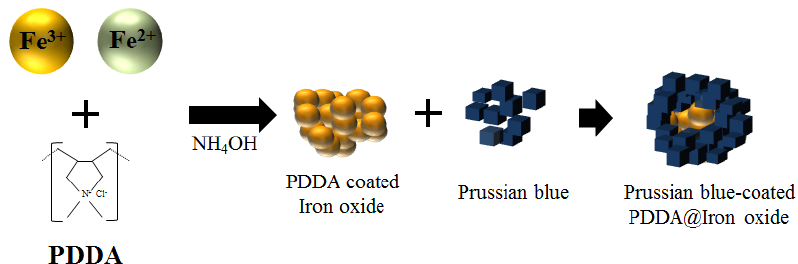
Figure 1. Synthetic procedures for the Prussian blue-coated magnetic nanoparticles. PDDA, poly(diallyldimethylammonium chloride).